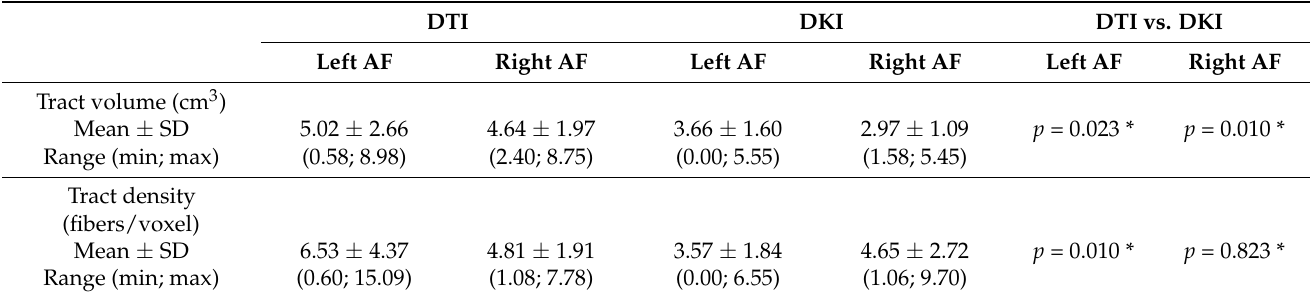
Table 6. Results of fiber tractography of the AF in